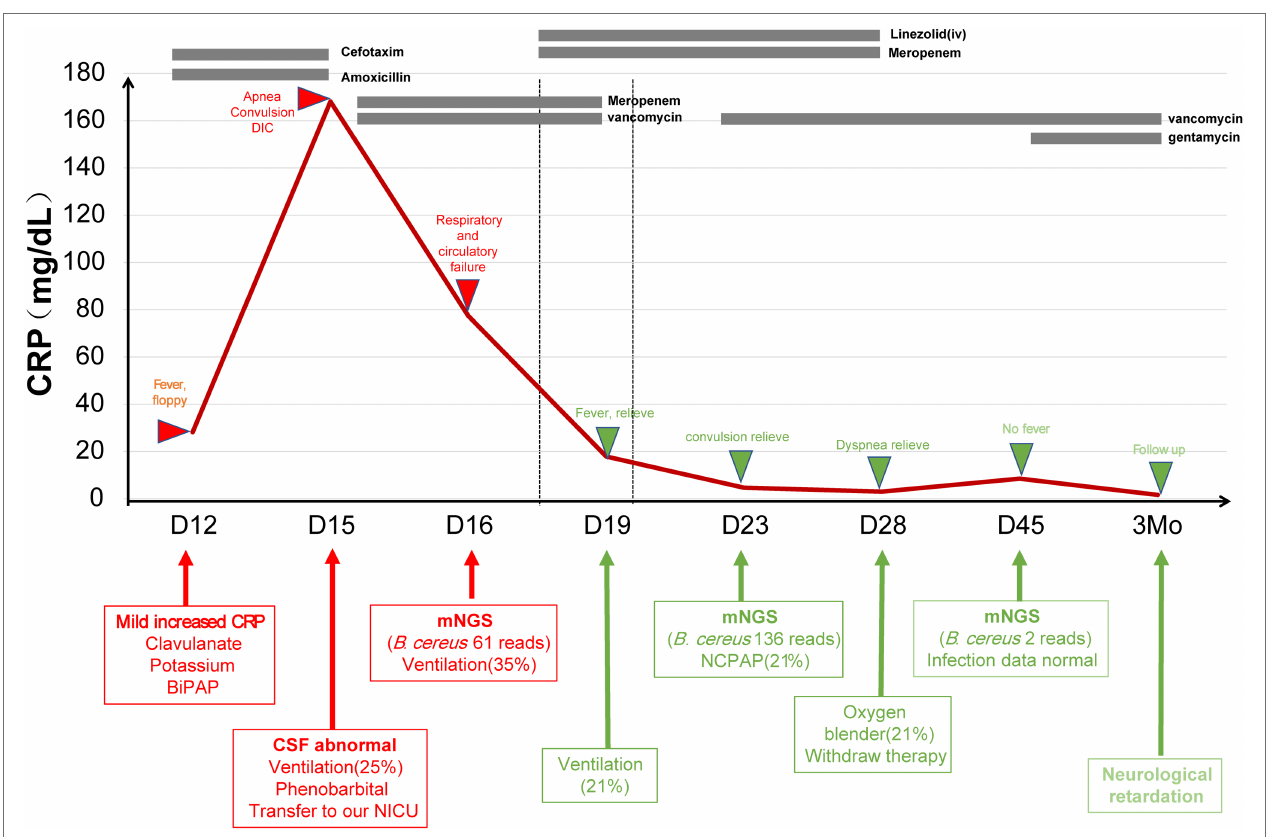
FIGURE 5 | The treatment course in Bacillus cereus case. CRP, C-reactive protein; CSF, cerebral spinal fluid; NICU, neonatal intensive care unit; B. cereus , Bacillus cereus ; and NCPAP, nasal continuous positive airway